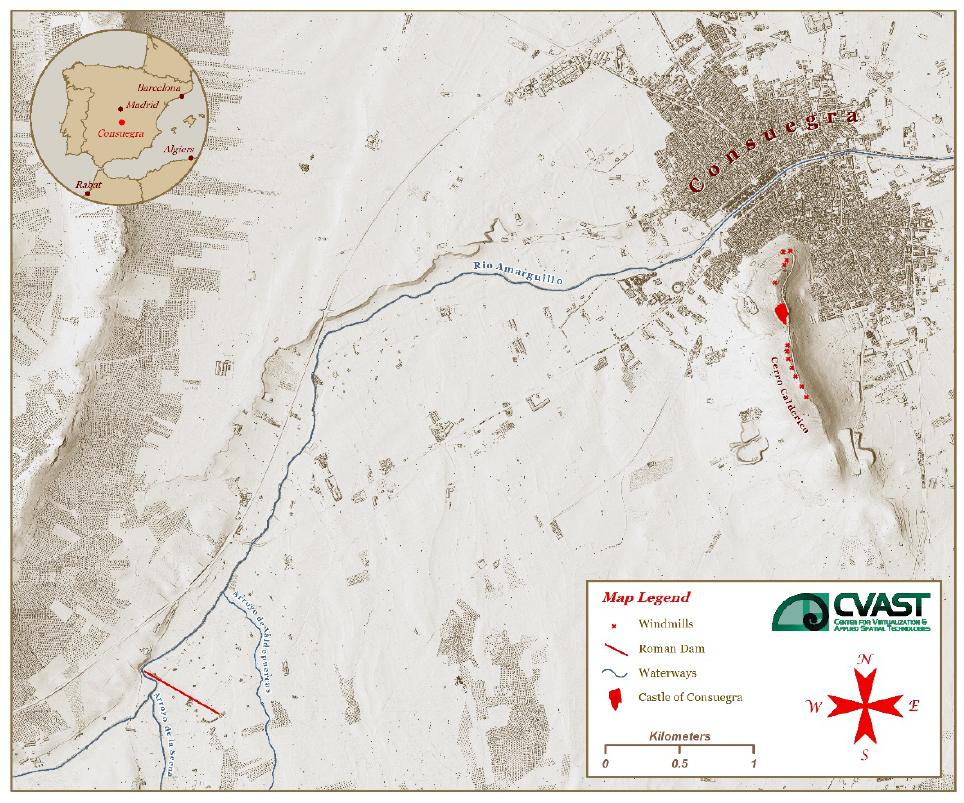
Figure 1. Map showing location of Roman Dam, related water features and Castillo de